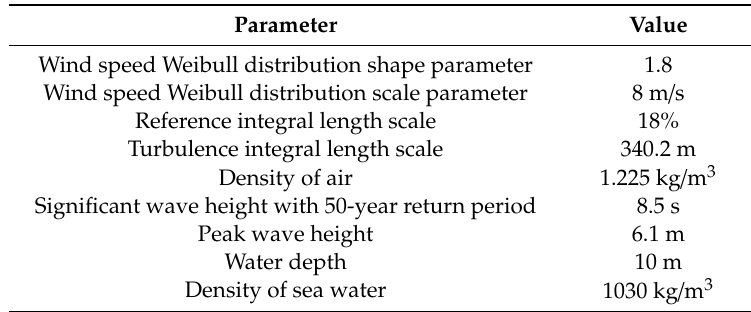
Table 2. Environmental site conditions [20].